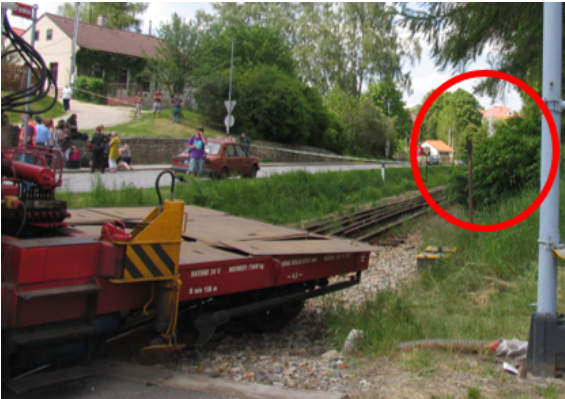
Figure 1. Vegetation Intruding Visibility Splays on Level Crossing (source Police Czech Republic).